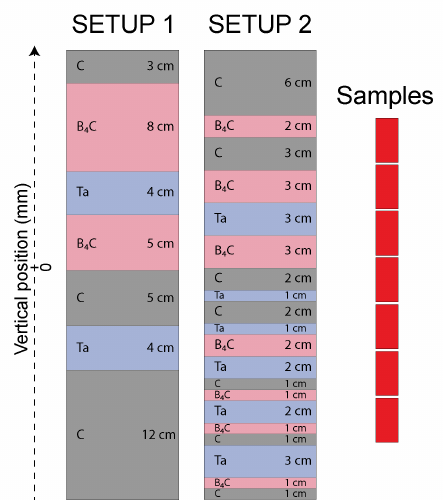
Figure 2. The two setups of segmented target utilized for the coating deposition with height reference of the sample placement. The middle of the target was assigned as 0